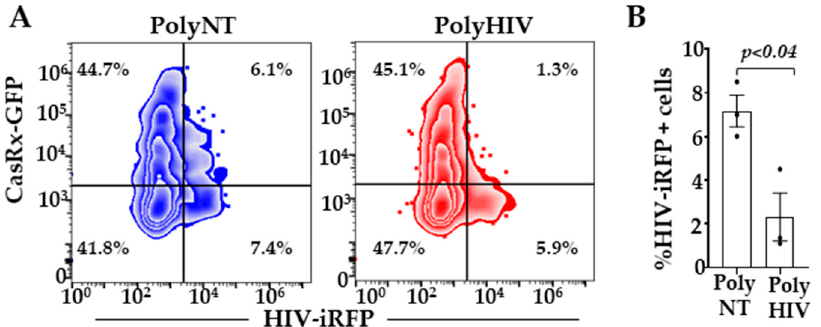
Figure 4. CasRx-silencing inhibited HIV-1 replication in CD4 + T cells. We transfected activated CD4 + T cells with pVax1-CasRx-GFP, non-targeting (polyNT), or HIV-targeting (polyHIV) gRNA plasmids by nucleofection (n = 3 distinct donors) and infected the cells with HIV-iRFP. ( A ) We measured HIV-iRFP expression 48 h post-infection by flow cytometry; ( B ) %iRFP expressing cells in polyHIV vs. polyNT gRNAs transfected cells were compared. The means ± s.e.m. are depicted as horizontal and vertical bars for each group, respectively. Each dot represents an individual donor. The paired t -test was used for statistical comparisons, and two-tailed p values are indicated.